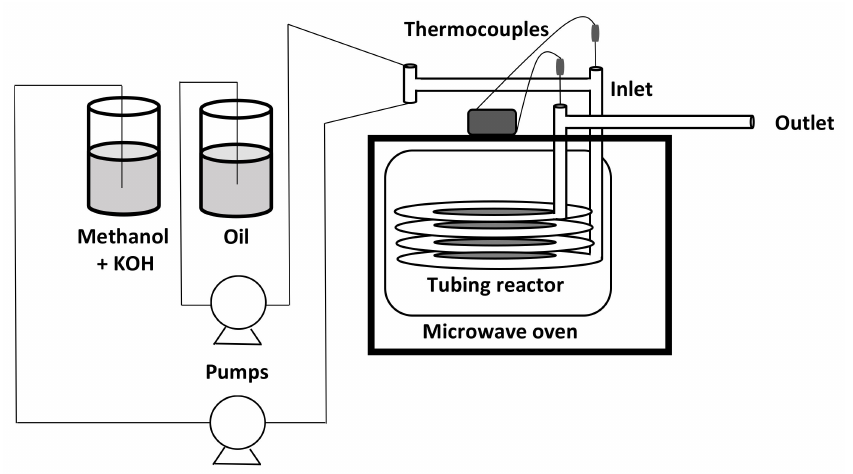
Figure 19. Microwave flow system